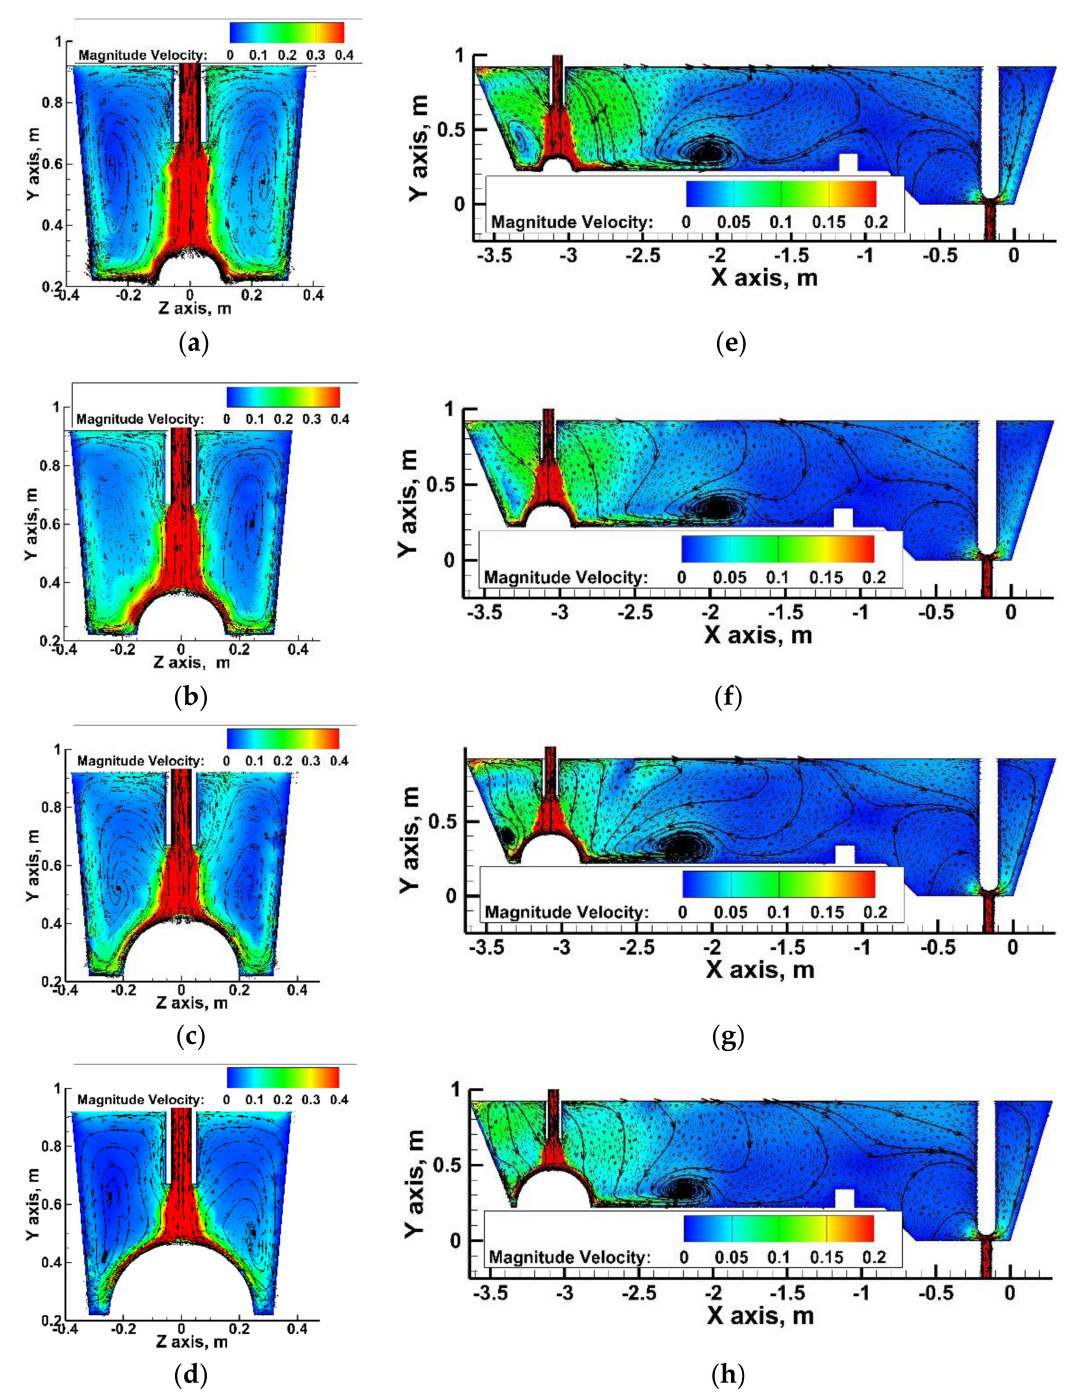
Figure 4. Liquid steel flow in the tundish with hemisphere SFC: ( a ) pouring zone (transversal plane—case No. 2), ( b ) pouring zone (transversal plane—case No. 3), ( c ) pouring zone (transversal plane—case No. 4), ( d ) pouring zone (transversal plane—case No. 5), ( e ) pouring and stopper rod zones (longitudinal plane—case No. 2), ( f ) pouring and stopper rod zones (longitudinal plane—case No. 3), ( g ) pouring and stopper rod zones (longitudinal plane—case No. 4), ( h ) pouring and stopper rod zones (longitudinal plane—case No.